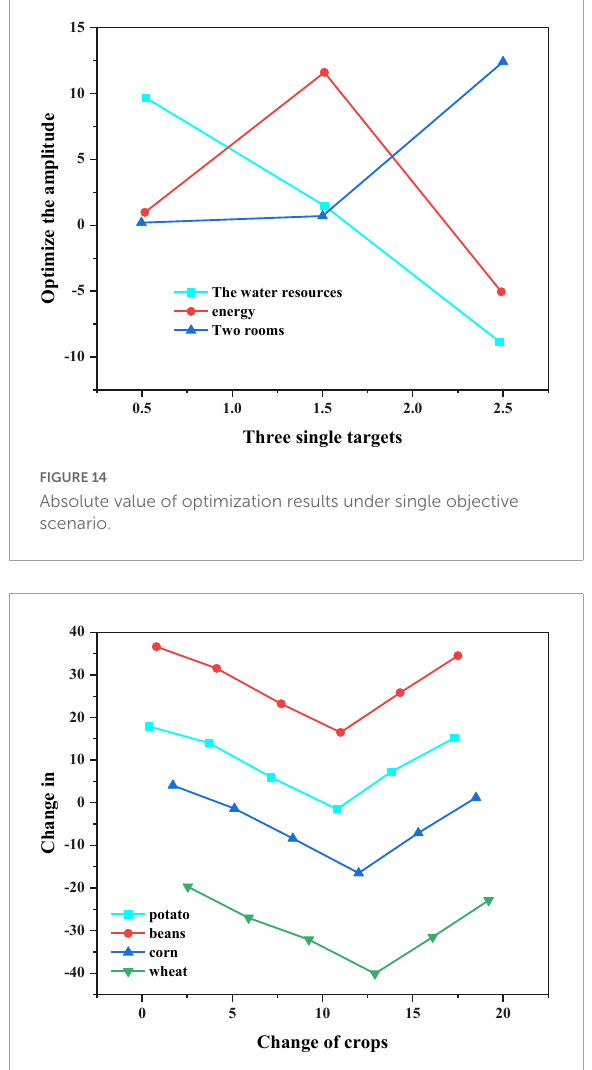
FIGURE15 Optimization results of w-e-f relationship of main